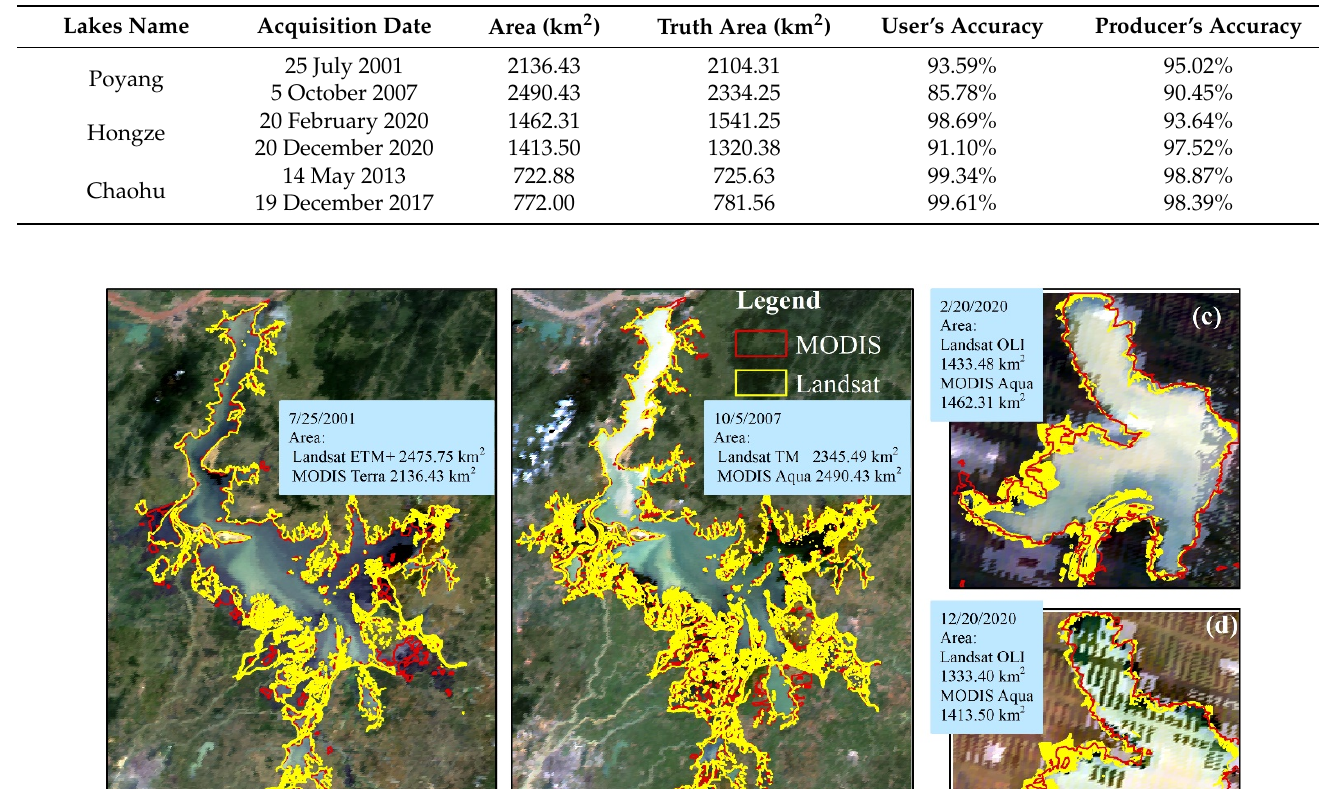
Table 1. Validation of the MODIS water extraction maps. Visual discrimination was used to obtain the